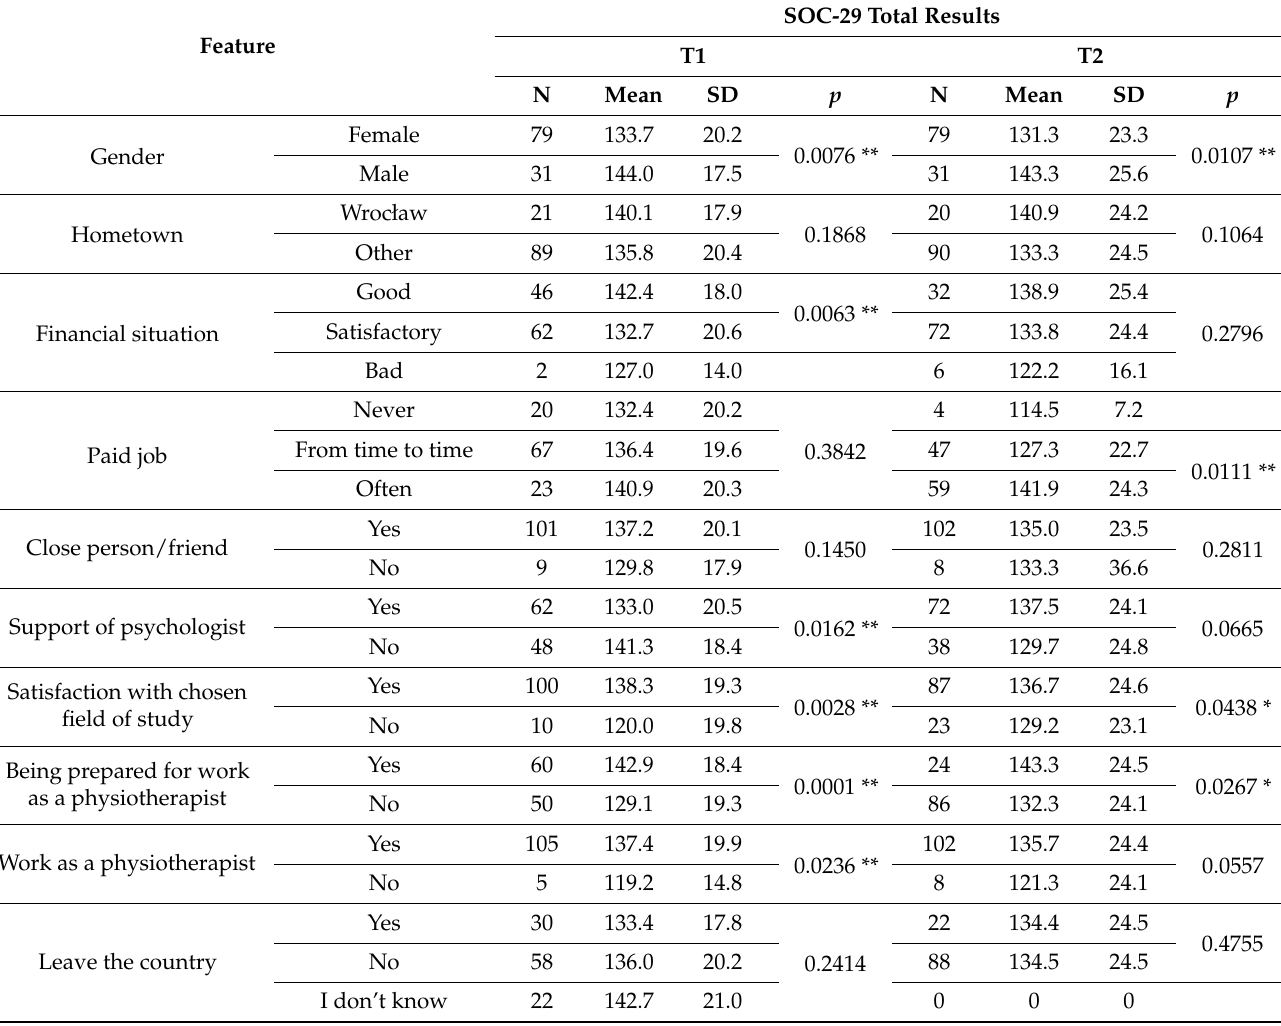
Table 5. The SOC-29 scores in T1 and T2 of selected groups of students (Student t -test for dependent groups or the ANOVA variance for three groups with at least five